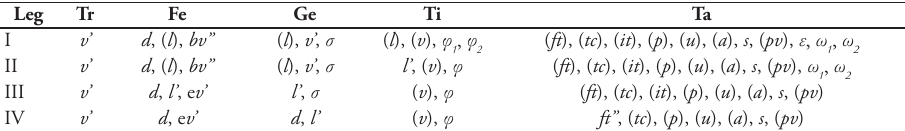
Table 3. Leg setation and solenidia of adult Eurostocepheus (Eurostocepheus) sinutus sp. nov. and Eurosto- cepheus (Eurostocepheus) mahunkai Mondal & Kundu,